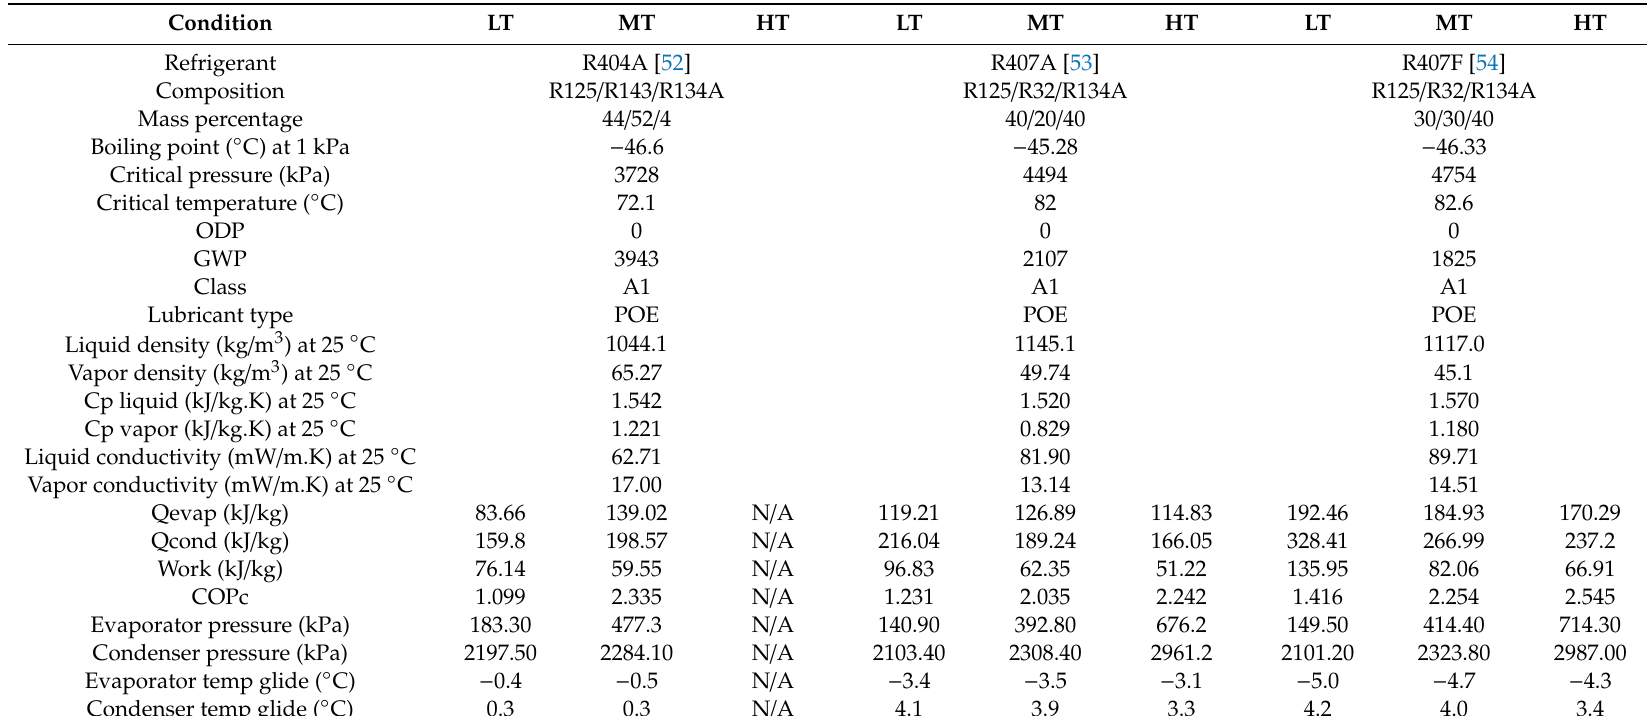
Table 5. Properties of R404A, R407A, and